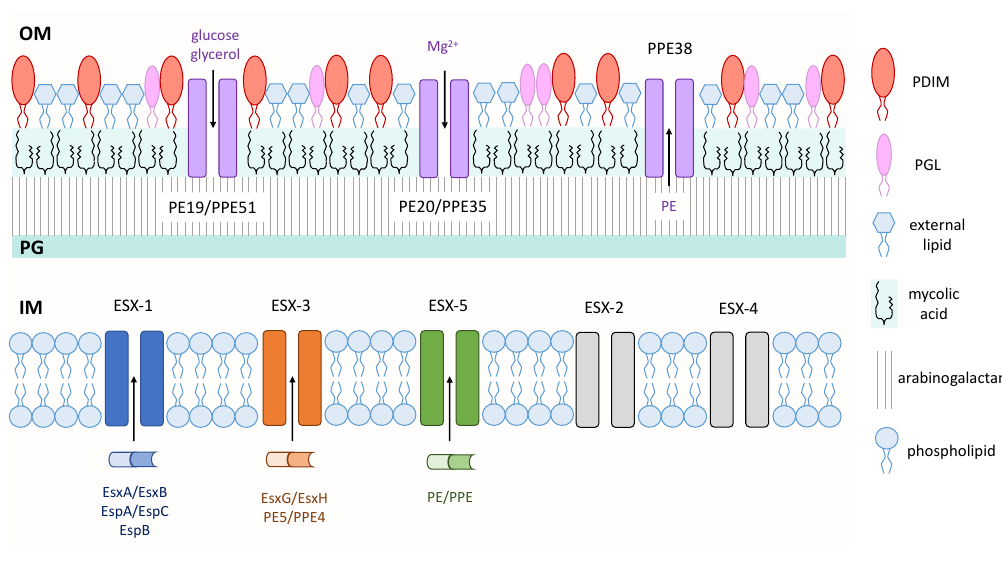
Figure 1. Virulence factors of mycobacteria. Three type VII secretion systems—ESAT-6 secretion system-1 (ESX-1), ESX-3, and ESX-5—secrete proteins across the IM. Pro-Glu (PE)/Pro-Pro-Glu (PPE)